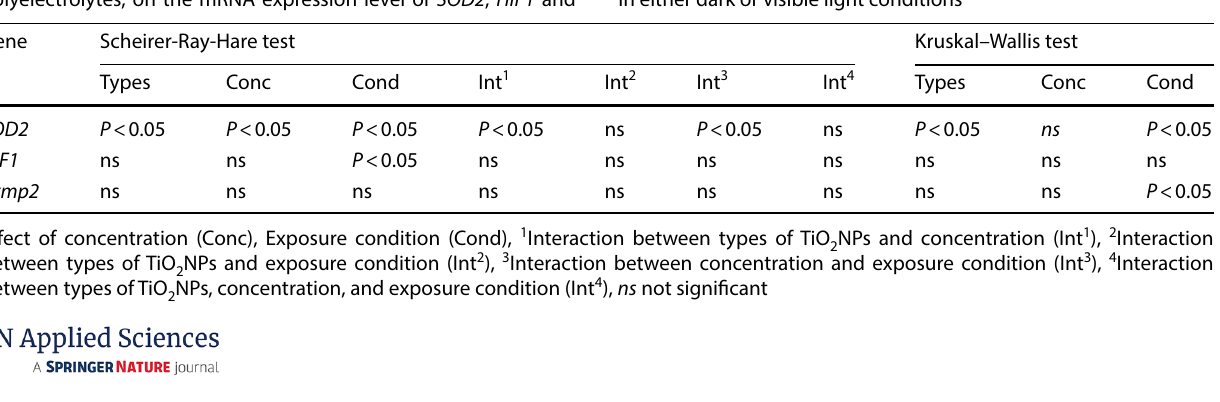
Pxmp2 in D. rerio embryos. Exposures were conducted at three par- ticle concentrations (0, 500 and 1000 mg/L), for 3 h exposure time, in either dark or visible light conditions